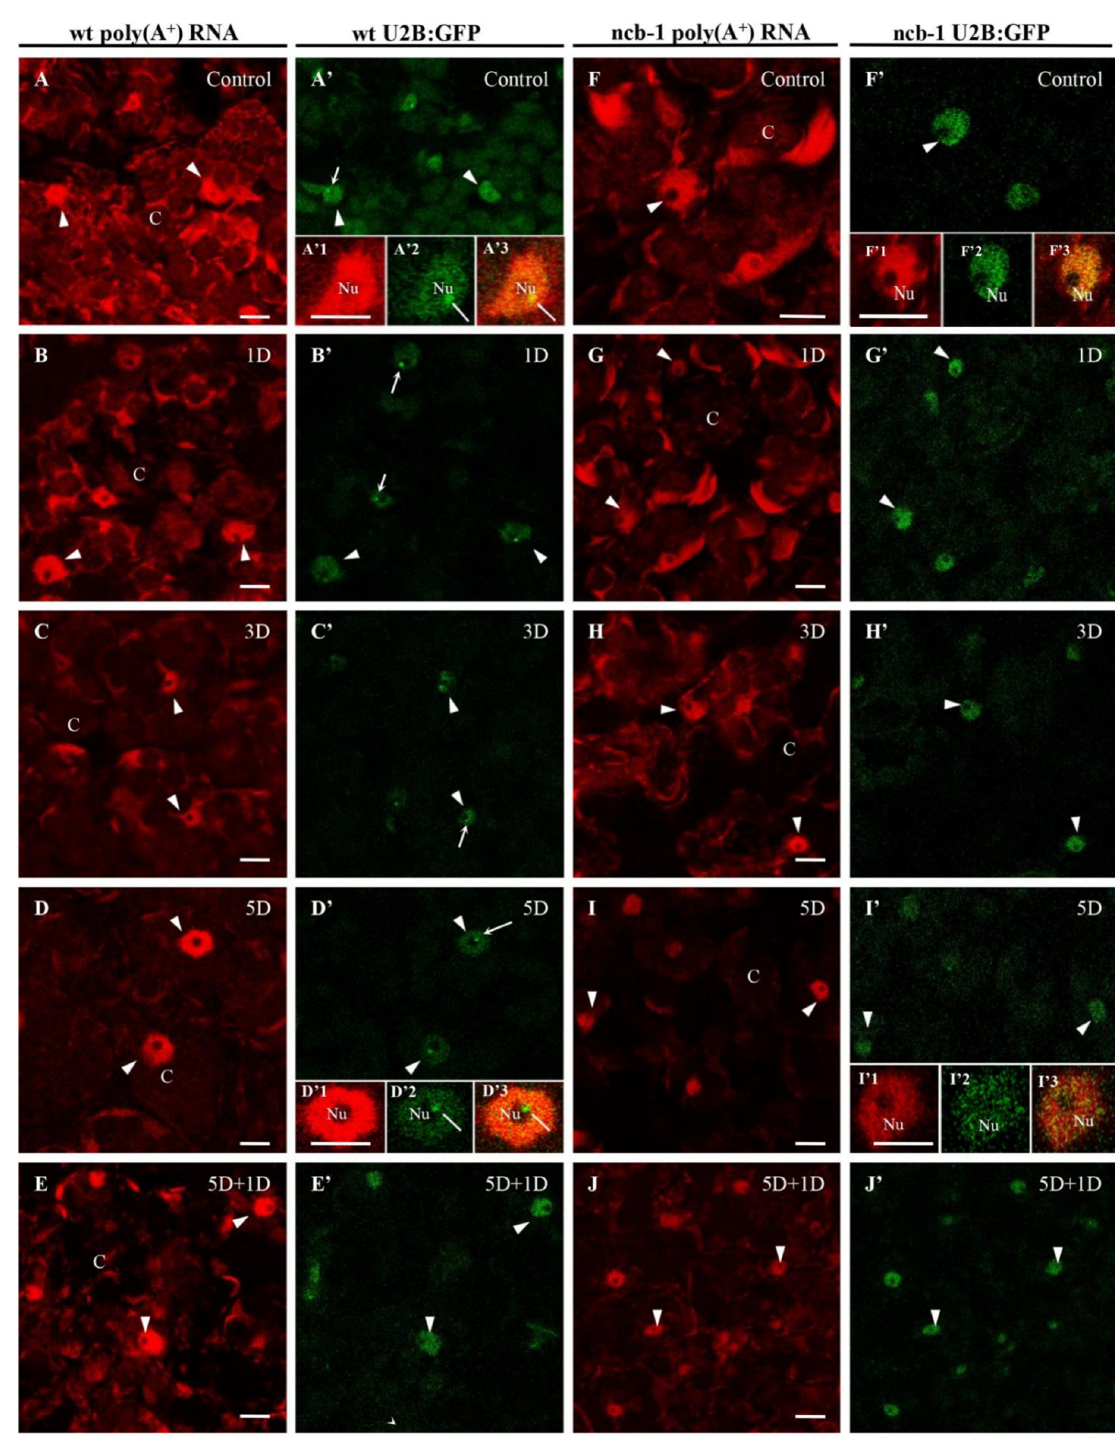
Figure 2. Localization of poly(A + ) RNA by whole-mount FISH in leaves in wt U2B”:GFP ( A – E ) and ncb-1 U2B”:GFP ( F – J ) cultivated to control ( A , F ) hypoxia ( B – D , G – I ) and reoxygenation ( E , J ) condition. Identification nuclei and CBs by U2B”-GFP ( A’ – J’ ). 1, 3, 5H—hours and 1, 5D—days of hypoxia, 5D + 1D—5 days of hypoxia and 1-day reoxygenation (indicated in the top right corner of the image). The inserts show enlarge, nuclei, and CBs in wt ( A’1 – A’3 , D’1 – D’3 ) and ncb-1 ( F’1 – F’3 , I’1 – I’3 ). Arrowhead—nuclei, arrow—Cajal bodies; C—cytoplasm, Nu—nucleolus; in inserts localization of poly(A + ) RNA w nuclei ( A’1 , B’1 , D’1 , I’1 ), identification of nuclei and CBs ( A’2 , B’2 , D’2 , I’2 ) with U2B”-GFP and merge ( A’3 , B’3 , D’3 , I’3 ). Bar 10 µm.